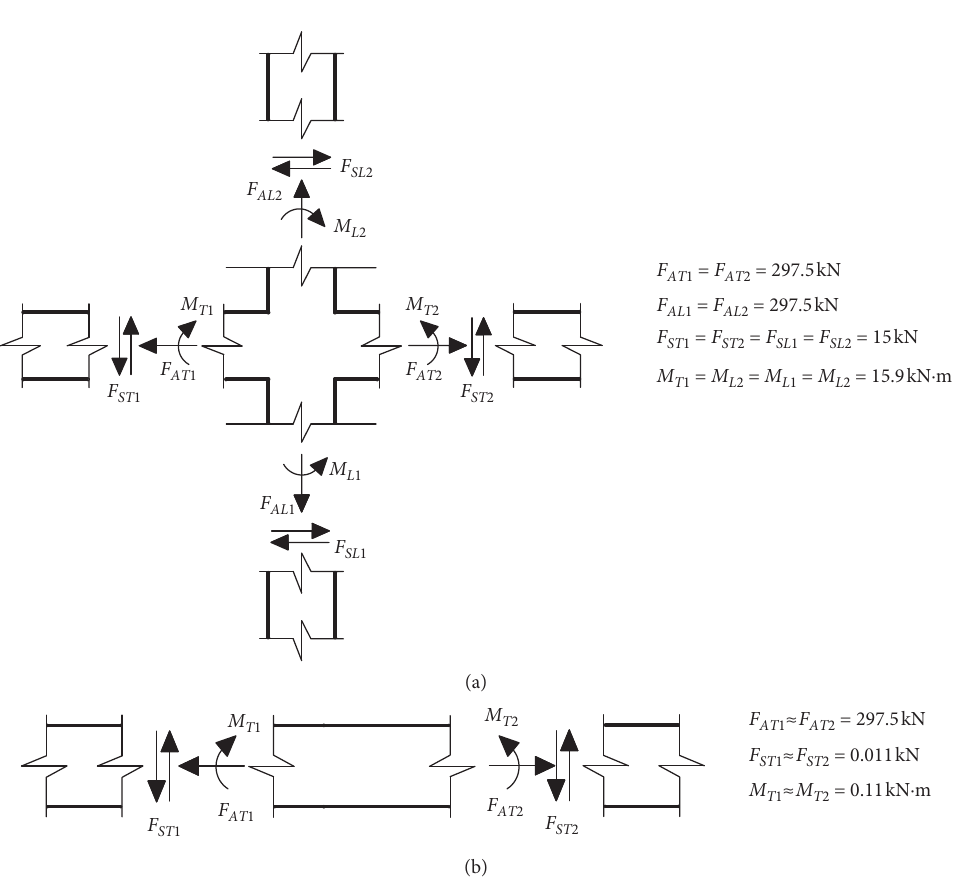
Figure 15: Force diagram of pipelines: (a) cruciform pipe; (b) straight